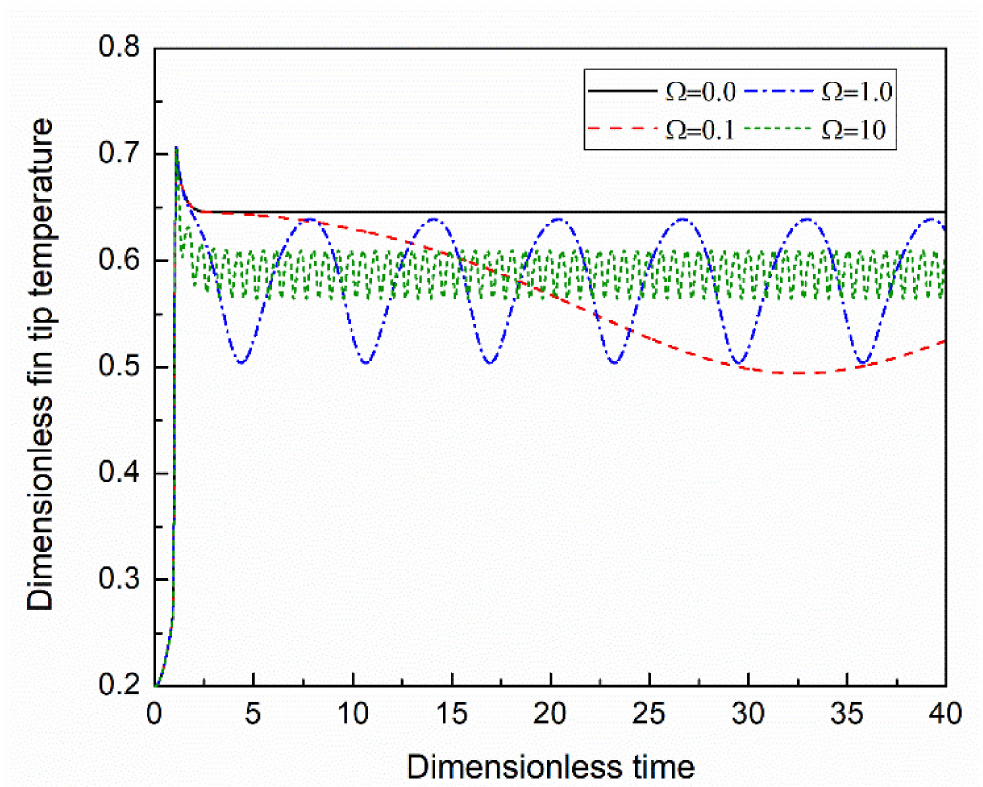
Figure 8. The variation of fin tip temperature at different values of Ω .